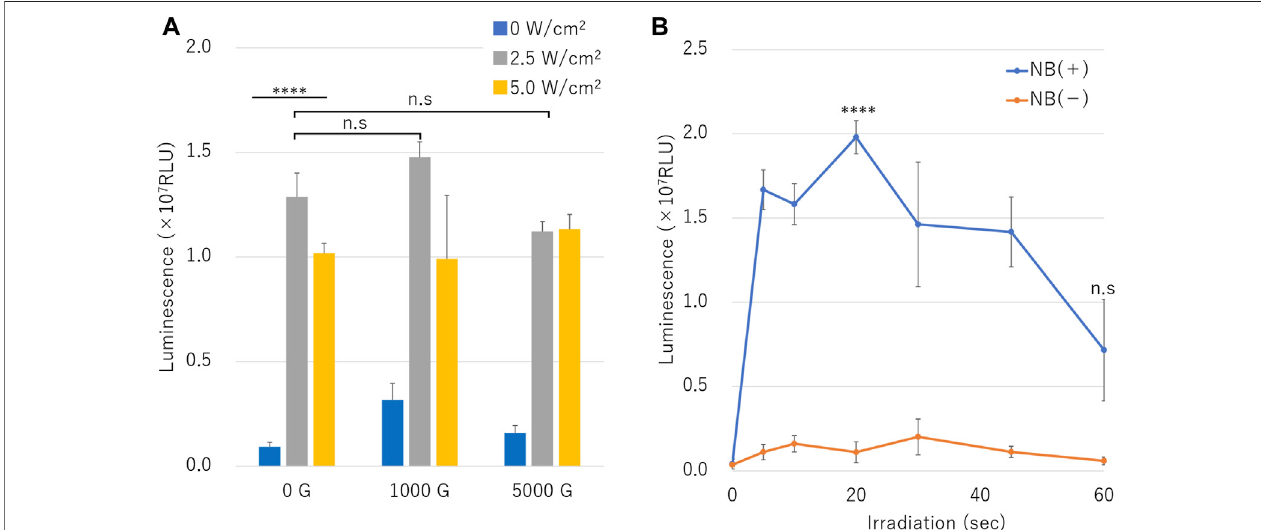
FIGURE9| Cellviabilityaftersonication.Cellviabilityaftersonicationwith orwithoutnanobubbles.Thedataarepresentedasthemean±standarderror of the mean (s.e.m.). Statistical signi fi cance was assessed unpaired t -test including Welch ’ s correction (n.s not signi fi cant.) ( N = 3).